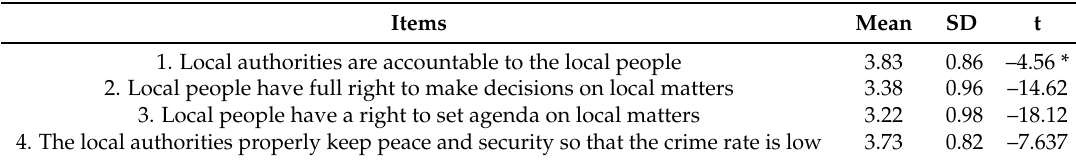
Table 3. One-sample t -test on respondents’ views on power relations (test value = 4 a ) (N = 518).